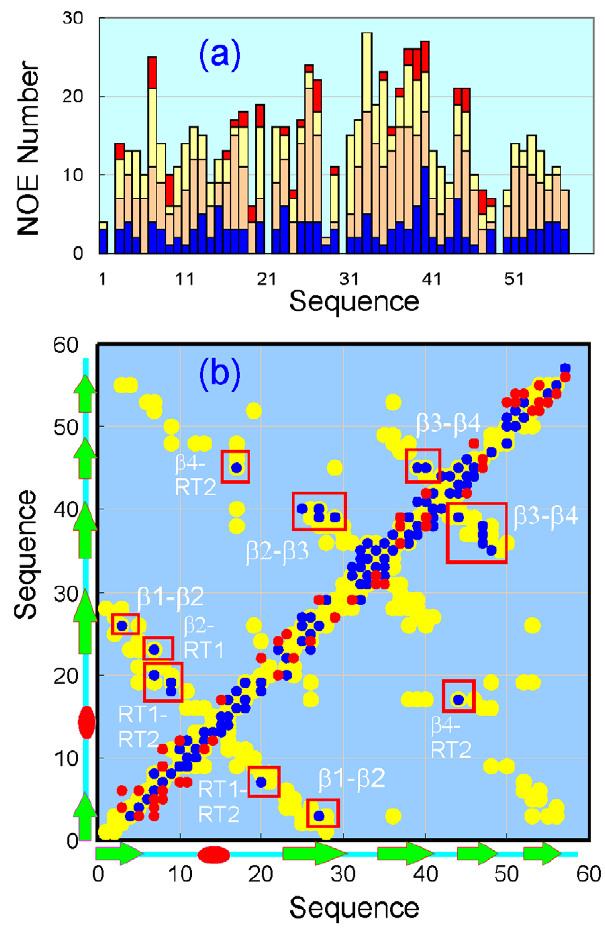
Figure 7. NOE plots. (a). NOE numbers identified from a 15 N-HSQC- NOESY spectrum of V22-SH3. Blue bars: intra-residual NOEs; brown bars: sequential NOEs; yellow bars: medium-range NOEs and red bars: long- range NOEs. (b). NOE contact map: yellow spots: NOEs of the wild-type SH3 domain associated with the published NMR structure determined at pH 6.5 [18]. Blue spots: native-like NOEs of V22-SH3. Red spots: non- native NOEs of V22-SH3. The persistent long-range NOEs were highlighted by red